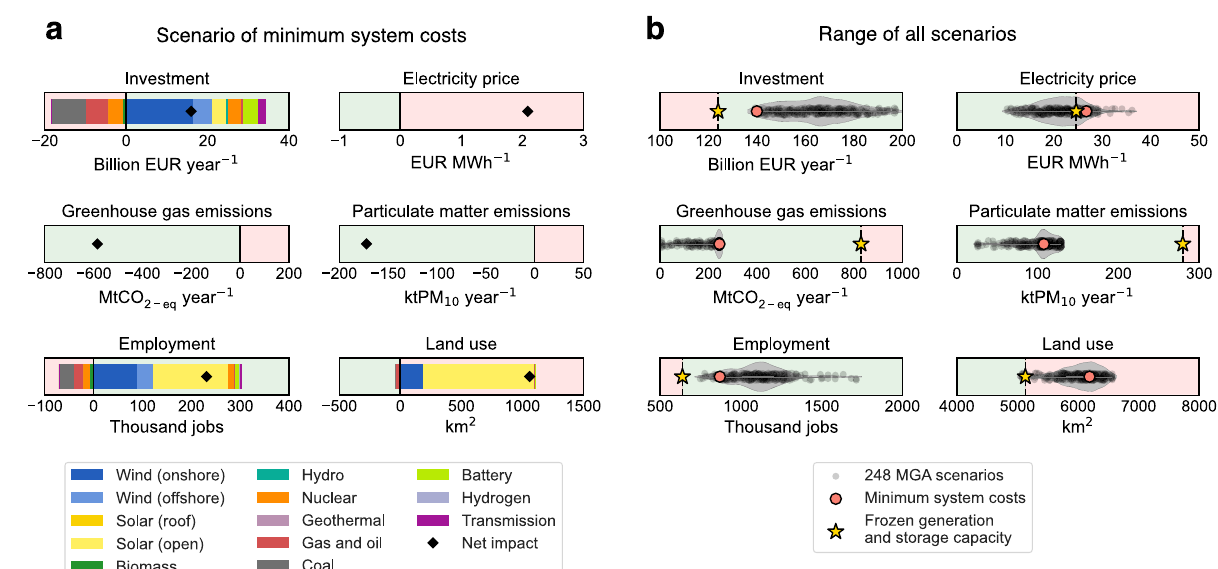
Fig. 2 | Continent-wide electricity sector impacts for all scenarios in 2035. a Bene fi ts and adverse impacts associated with the electricity sector for the sce- nario of minimum system costs, as compared to the scenario of frozen generation and storage capacity. Impacts on electricity prices are calculated as weighted annual average prices across all 296 NUTS-2 administrative regions 46 with elec- tricity demand as weights. Impacts on greenhouse gas and particulate matter emissions are calculated as net impacts across all technologies and regions. Impactsoninvestment,employment,andlandusearecalculatedascontinent-wide sums of technology-speci fi c bene fi ts and adverse impacts separately. Bene fi ts are highlighted in green and adverse impacts are highlighted in red. Impacts on investment and annual average electricity prices are endogenously calculated by